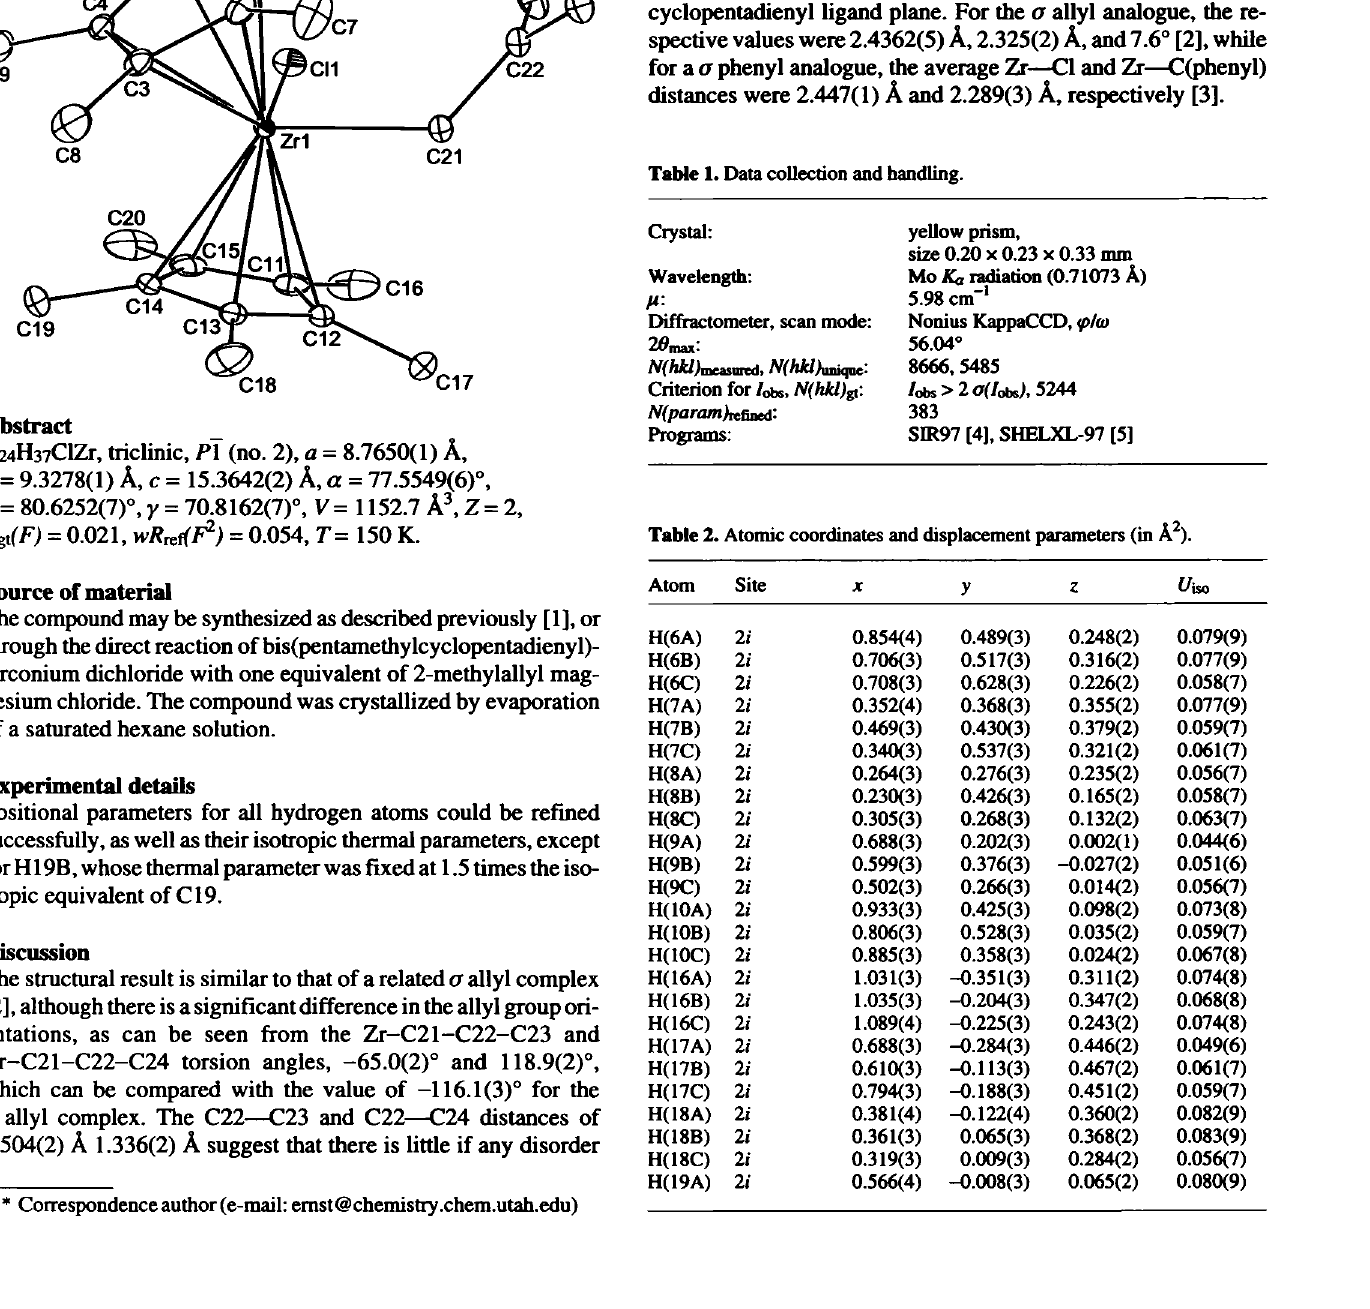
Table 1. Data collection and handling.